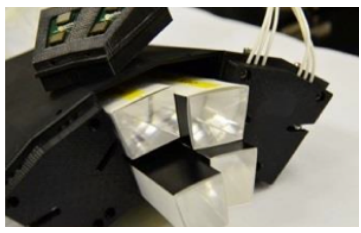
Figure 7. Some special-shaped CCALT LYSO crystals in their housing